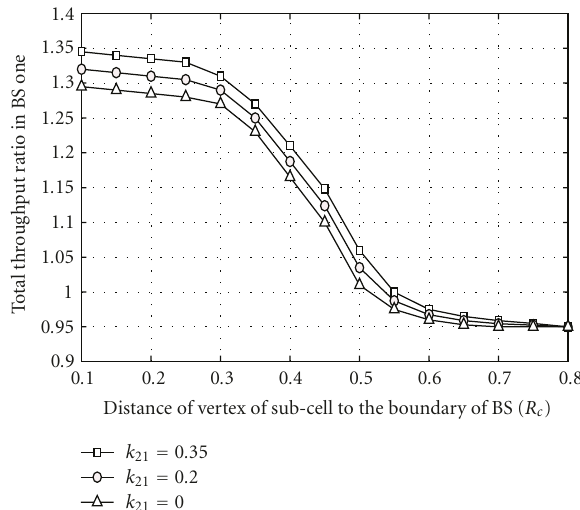
Figure 5: The ratio of the achieved throughput with relaying to the case without relaying in BS 1 for one-relaying and two-relaying cases versus the distance of the sub-cell to the BS for di ff erent values of k 21 .